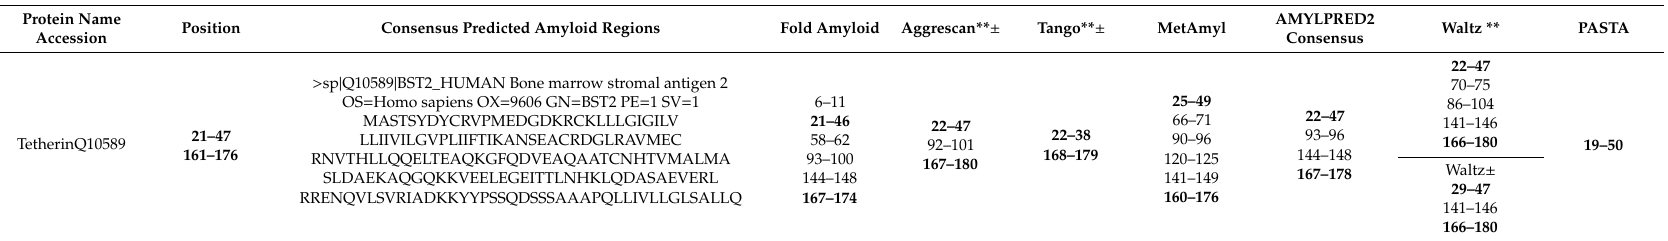
Table 7. Aggregating regions predicted in tetherin by seven servers. Consensus results are highlighted as regions predicted by at least six of the seven